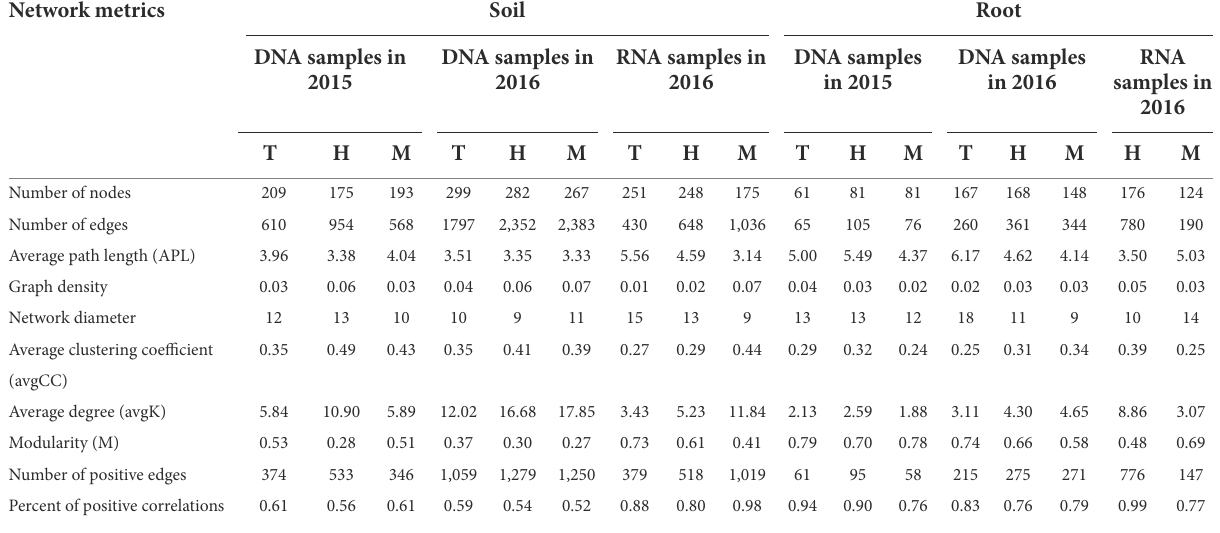
TABLE 2 Topological properties of the co-occurrence networks of total and active diazotrophs in the rhizosphere soil and rice roots during three growth periods. Network